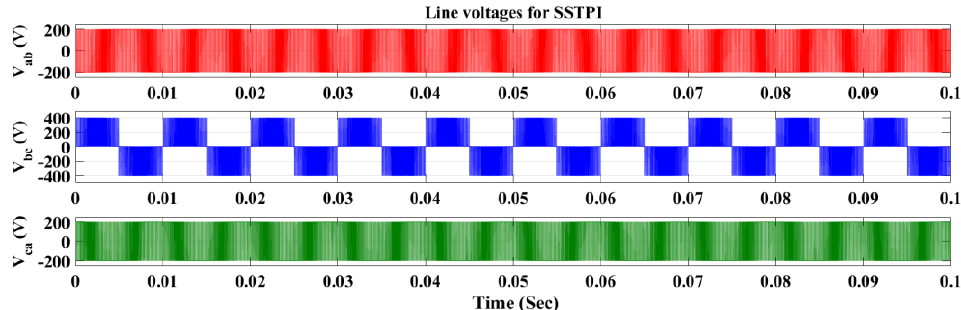
Figure 19. Output line voltages of